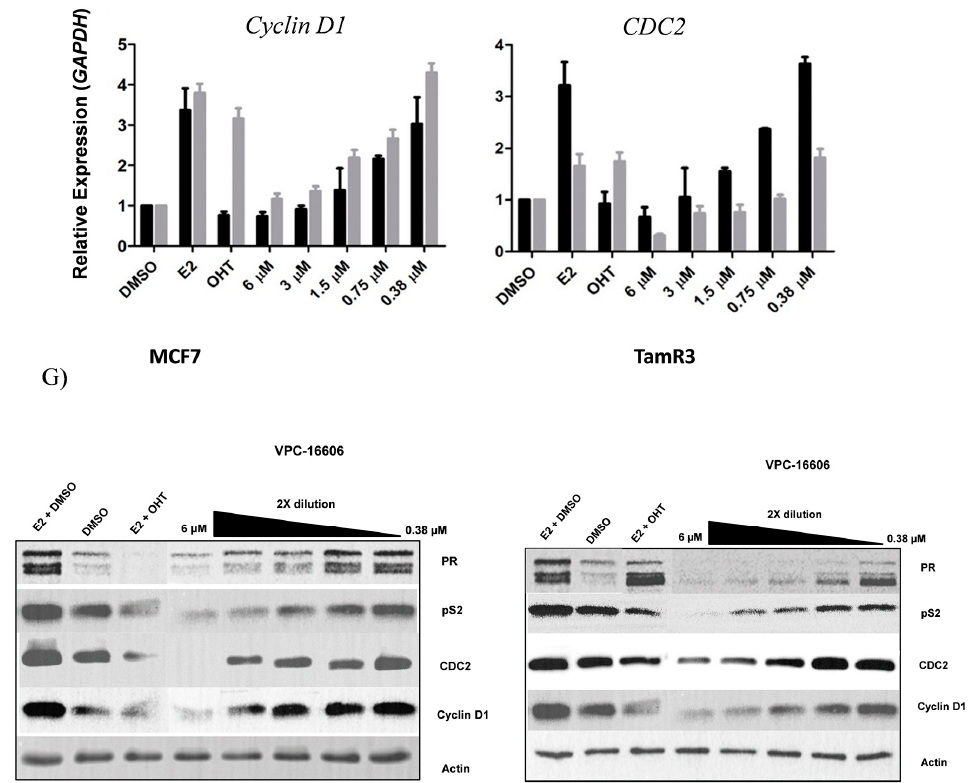
Figure 3. Activity profile of VPC-16606. ( A ) Dose-response curve illustrating the inhibitory effect of VPC- 16606 (IC 50 0.3 µM) on ER α transcriptional activity in T47DKBluc cells. ( B ) BLI dose-response curves (3– 100 µM) reflecting the direct binding of VPC-16606 to ER α LBD. ( C ) Mammalian two-hybrid assay in